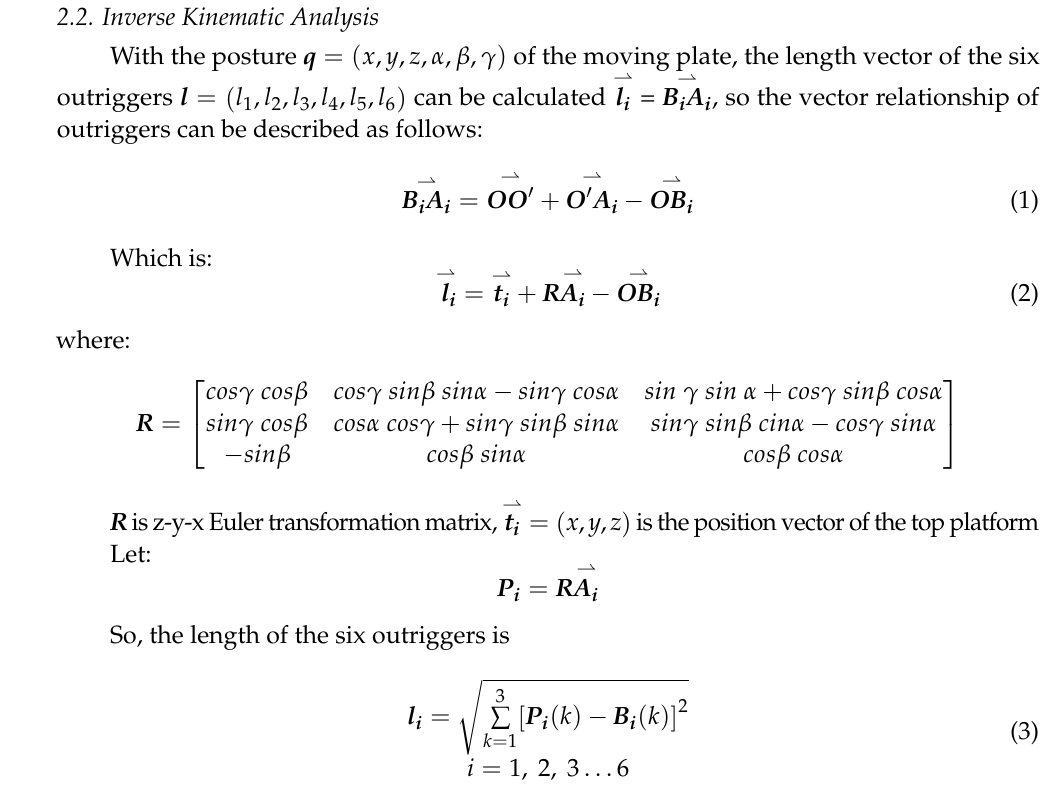
Figure 1. Simplified structure and vector geometry diagram of the SGP. ( a ) Main components of SGP. ( b ) Kinematic vector diagram of single outrigger.